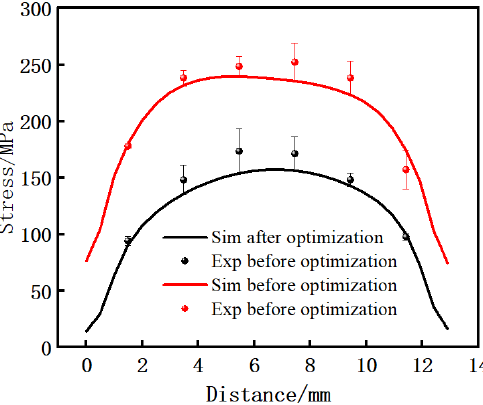
Figure 16. Distribution of the residual stress in the lengthwise direction parallel to the welding surface and 1 mm away from the welding surface under the two welding parameters.